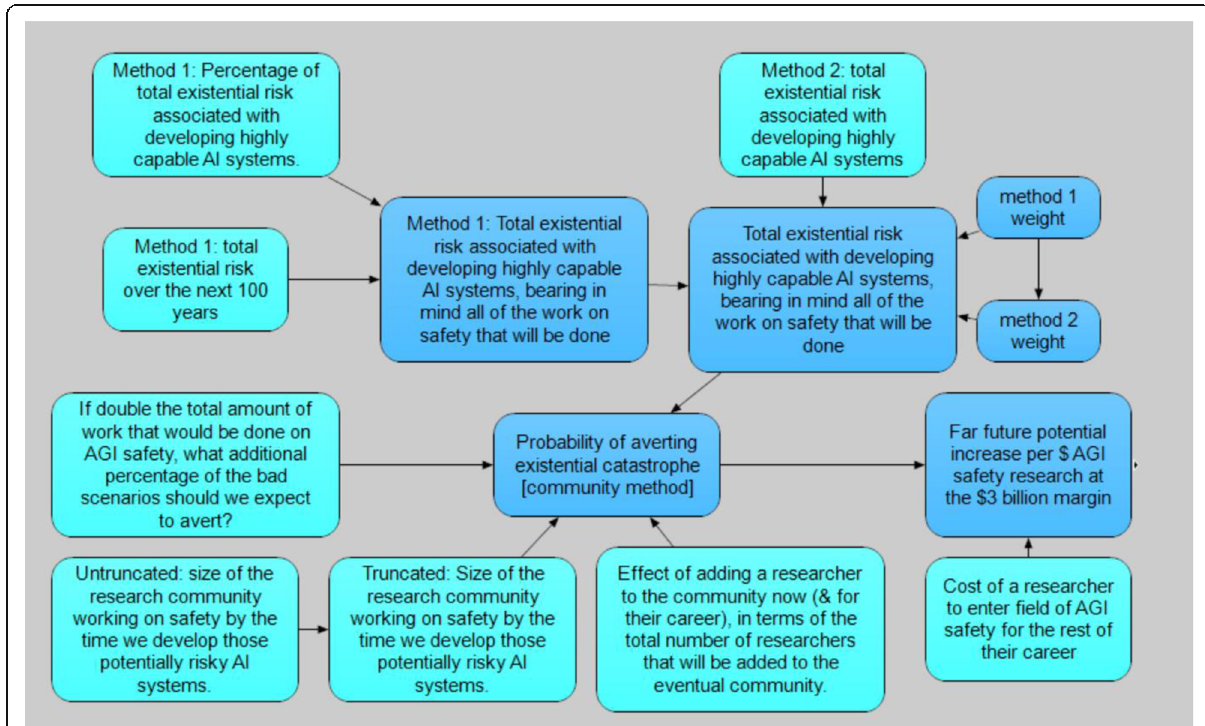
Fig. 4 AGI safety cost-effectiveness